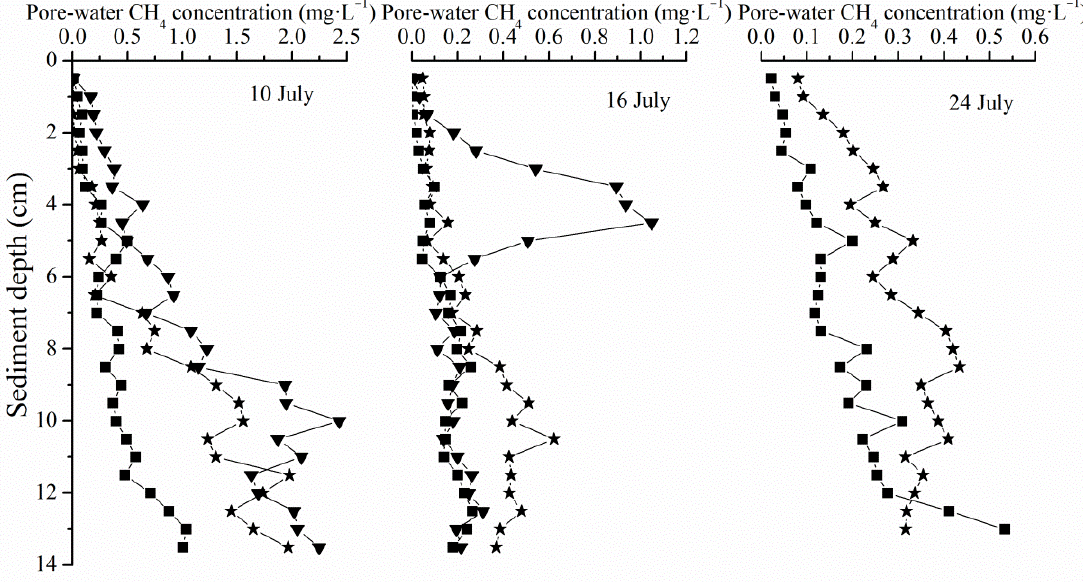
Figure 4. Sediment pore-water CH 4 concentrations in different inundation conditions.